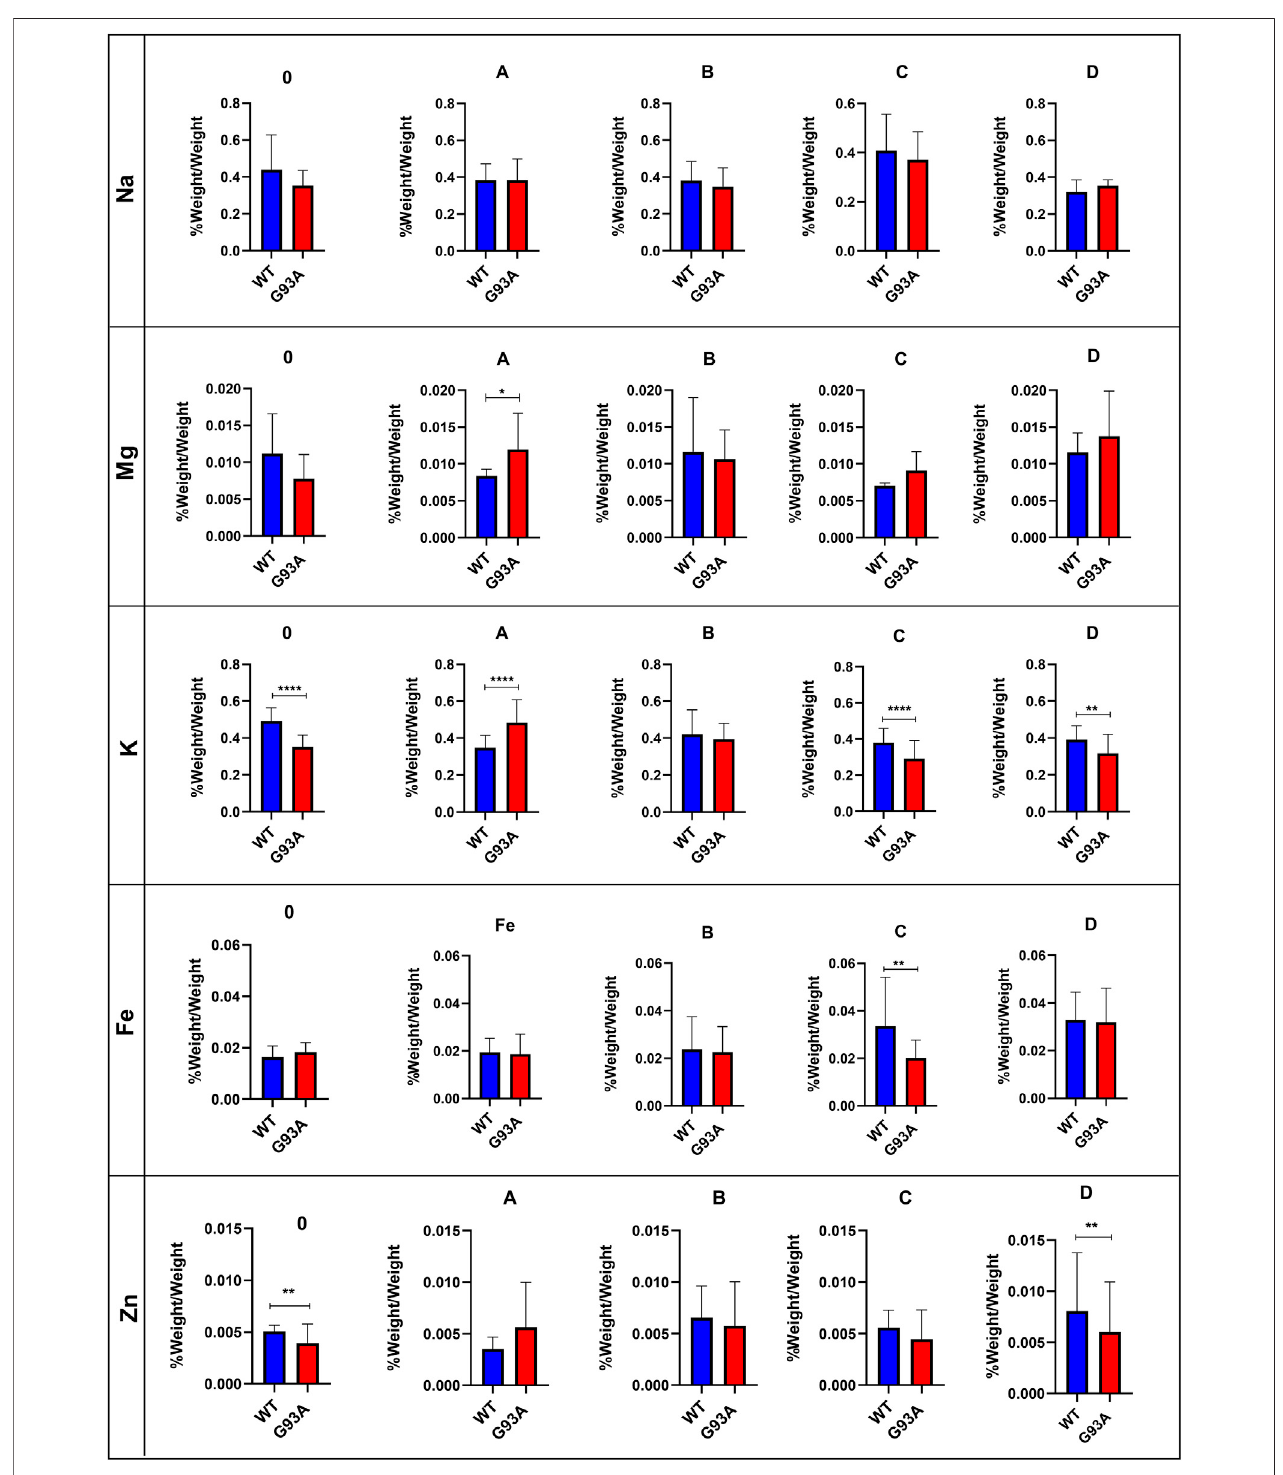
FIGURE 6 | Trace element and mineral levels of SOD1 G93A and SOD1 WT rats. * p ≤ 0.05, ** p ≤ 0.001 and *** p ≤ 0.0001.